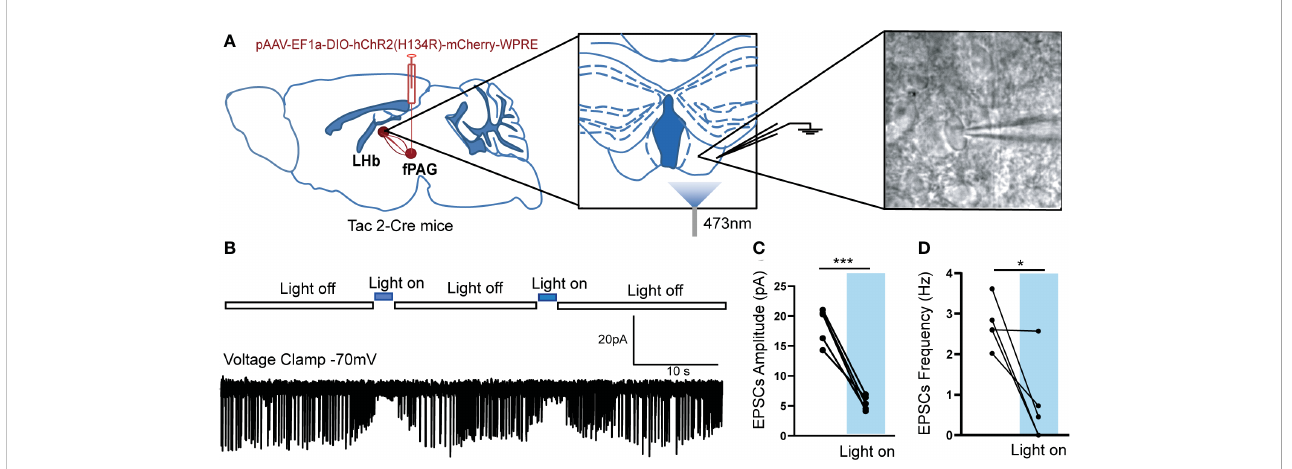
FIGURE 8 Optogenetically evoked EPSCs in LHb neurons projected from fPAG NKB-positive neurons. (A) Schematic of pAAV-EF1a-DIO-hChR2(H134R)-mCherry- WPRE injection into fPAG, a 470-nm laser application, and the recording con fi guration in the LHb. (B) Representative traces of light-evoked EPSCs recorded in LHb neurons in Tac2-cre mice. (C, D) Quanti fi cation of EPSC amplitudes (C) and frequencies (D) of LHb neurons with laser application in